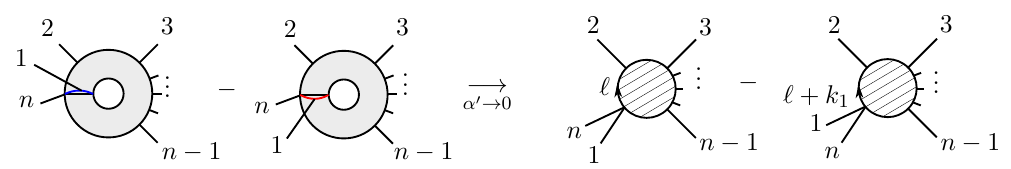
Figure 4 . Left-hand side: boundary terms along contours A and B as de(cid:12)ned in (cid:12)gure 2. Right- hand side: conjectured corresponding types of one-loop graphs. Notice the loop-momentum shift. contour B drops out, and the contour A gives an additional term that connects x = 0 to x = 1. One can then check that the phases of the momentum kernel, and the di(cid:11)erent terms